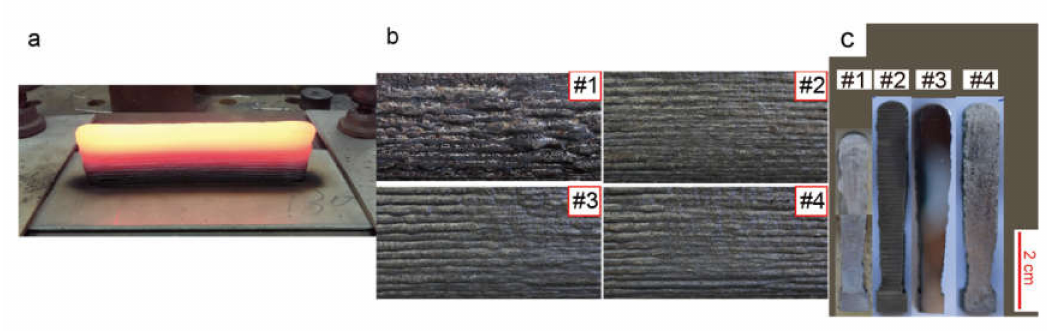
Figure 3. ( a ) Macro-morphology of deposited sample; ( b ) Weld bead morphology in the middle region of deposited samples; ( c ) cross-section of deposited